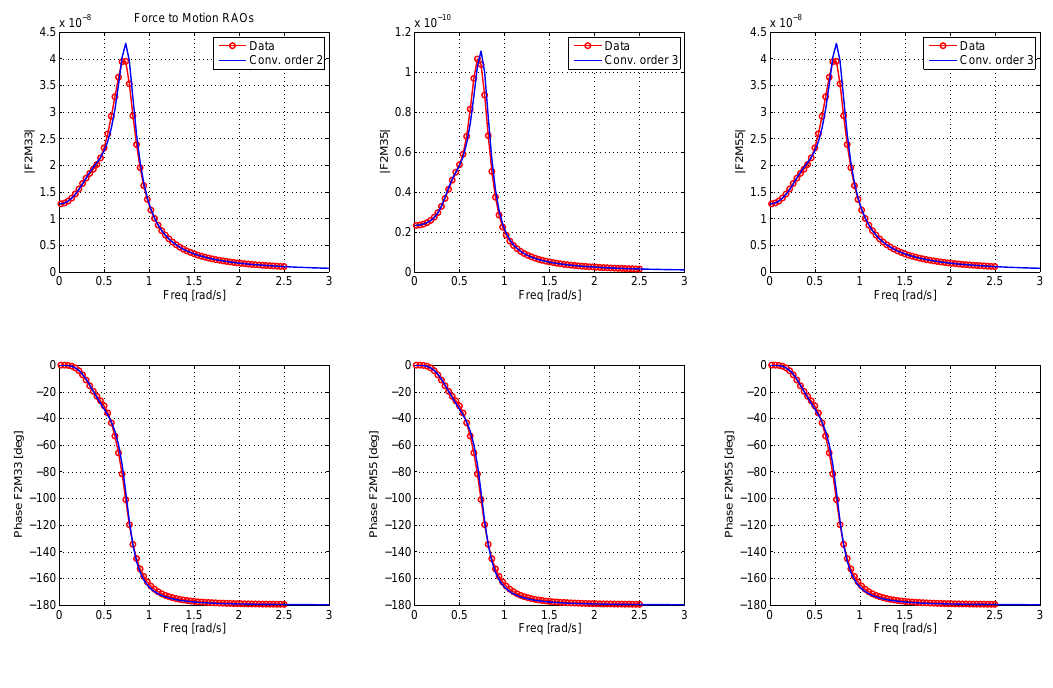
Figure 15: Force-to-displacement frequency response functions: non-parametric, and parametric based on fre- quency response curve